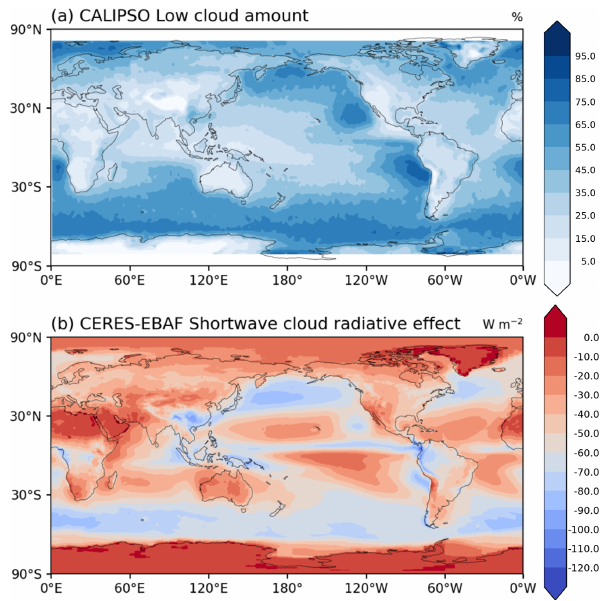
Figure 3. (a) Low cloud amounts from Cloud-Aerosol Lidar and Infrared Pathfinder Satellite Observation (CALIPSO) from Jan- uary 2007 to January 2010 and (b) shortwave cloud radiative ef- fect (SWCRE) from Clouds and Earth’s Radiant Energy System (CERES) Energy Balance and Filled (CERES-EBAF) product from 2001 to